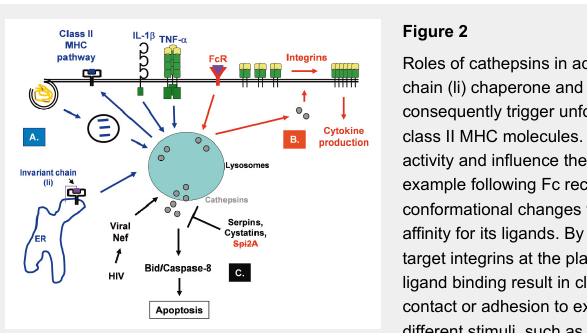
Roles of cathepsins in adaptive immunity. A. Lysosomal proteases remove the invariant chain (li) chaperone and introduce cleavages in endocytosed antigens which will consequently trigger unfolding and capture of processed antigen by newly synthesised class II MHC molecules. Moreover, cytokines (e.g. IL-1β, TNF-α) can modulate cathepsin activity and influence the class II MHC pathway. B. Activation of immune cells, for example following Fc receptors (FcR) ligation by immune complexes, induces conformational changes to surface receptors, such as β-integrins, increasing integrin affinity for its ligands. By an unexplained mechanism, cathepsins access the cytosol and target integrins at the plasma membrane. Both rearrangement of their cytoskeleton and ligand binding result in clustering of these molecules, thereby increasing cell-to-cell contact or adhesion to extracellular matrices. C. Following induction of apoptosis by different stimuli, such as the viral protein Nef, lysosomal cathepsins are released into the cytosol. Once in the cytosol, these proteases will induce the proteolysis of different targets (e.g. caspase-8, Bid, and anti-apoptotic Bcl-2 family members) and activate the enzymatic signalling cascade of apoptosis. In the cytosol, the cathepsin activity can be kept in check by